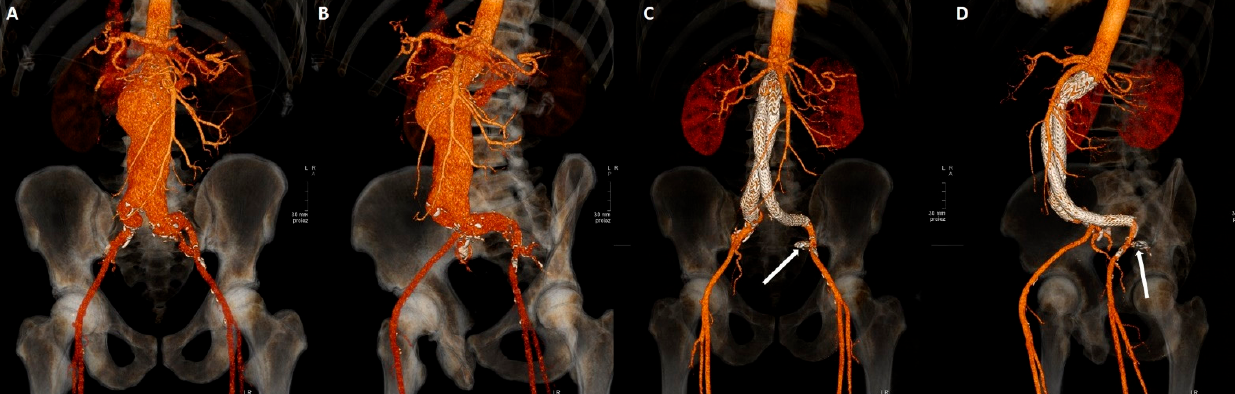
Figure 1. ( A ) Intraprocedural fluoroscopy image of a left ipogastrigc artery embolization with coils (arrows) using a Simmons-shape catheter. ( B ) Final digital subtraction angiography image at the end of the EVAR procedure showing complete exclusion of the left ipogastrigc artery.